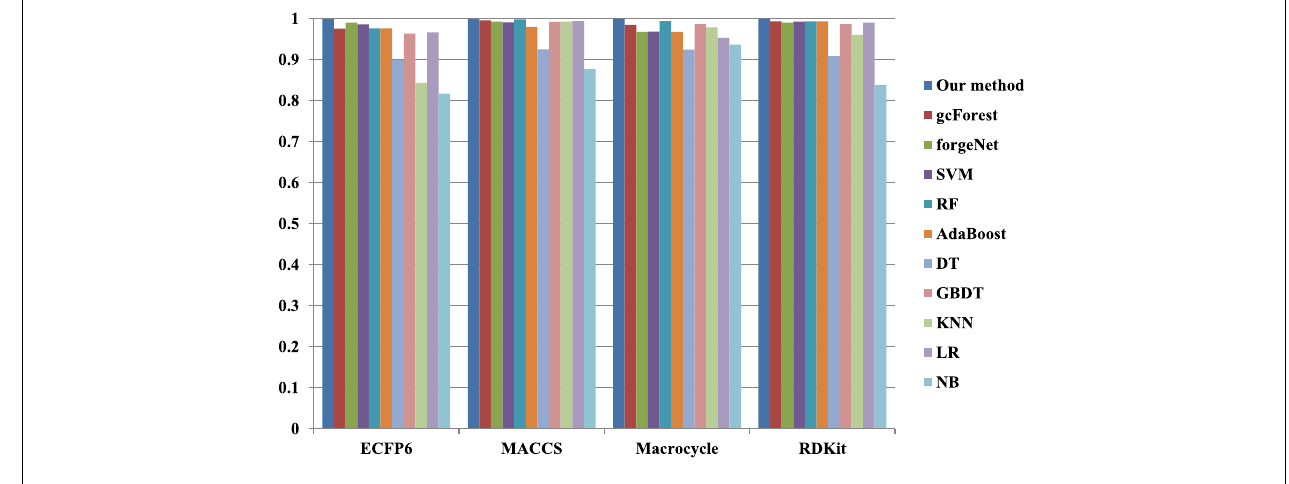
FIGURE 4 | AUC performances of 11 methods with hypertension dataset.